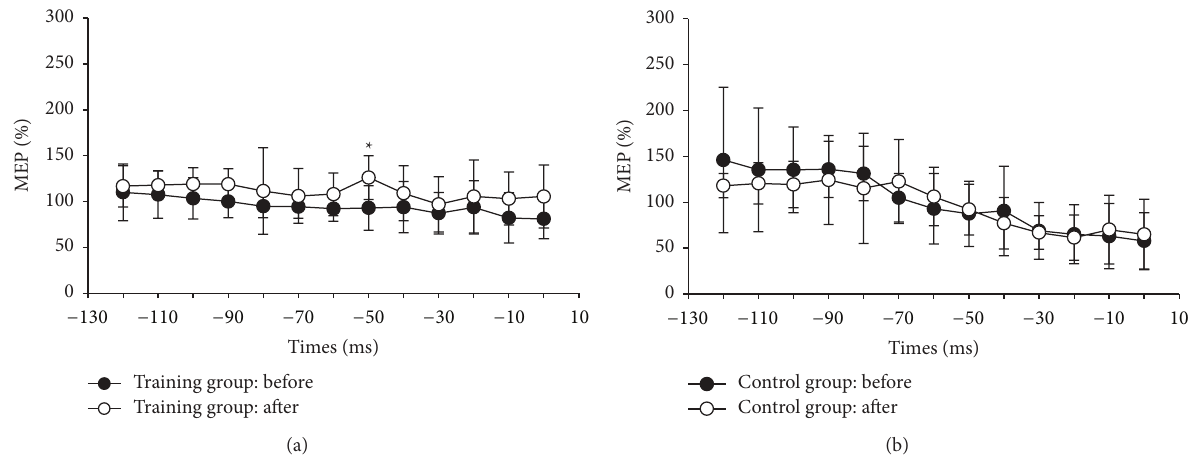
Figure4:ThenormalizedMEPamplitudesbeforeonsetlatencyoftheantagonistmuscleEMGoffastgoal-directedwristextensionmovement in the training group (a) and the control group (b). The black circles indicate the group mean before training, and the white circles indicate the group mean after the 4-week training program. The error bars indicate the standard